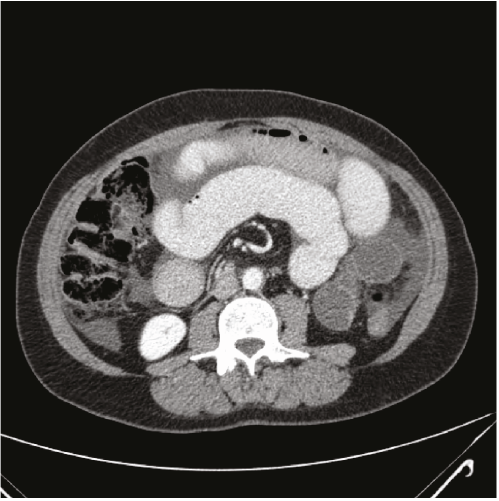
Figure 4: CT of the abdomen. Whirl sign at the base of the mesentery around the superior mesenteric artery consistent with midgut